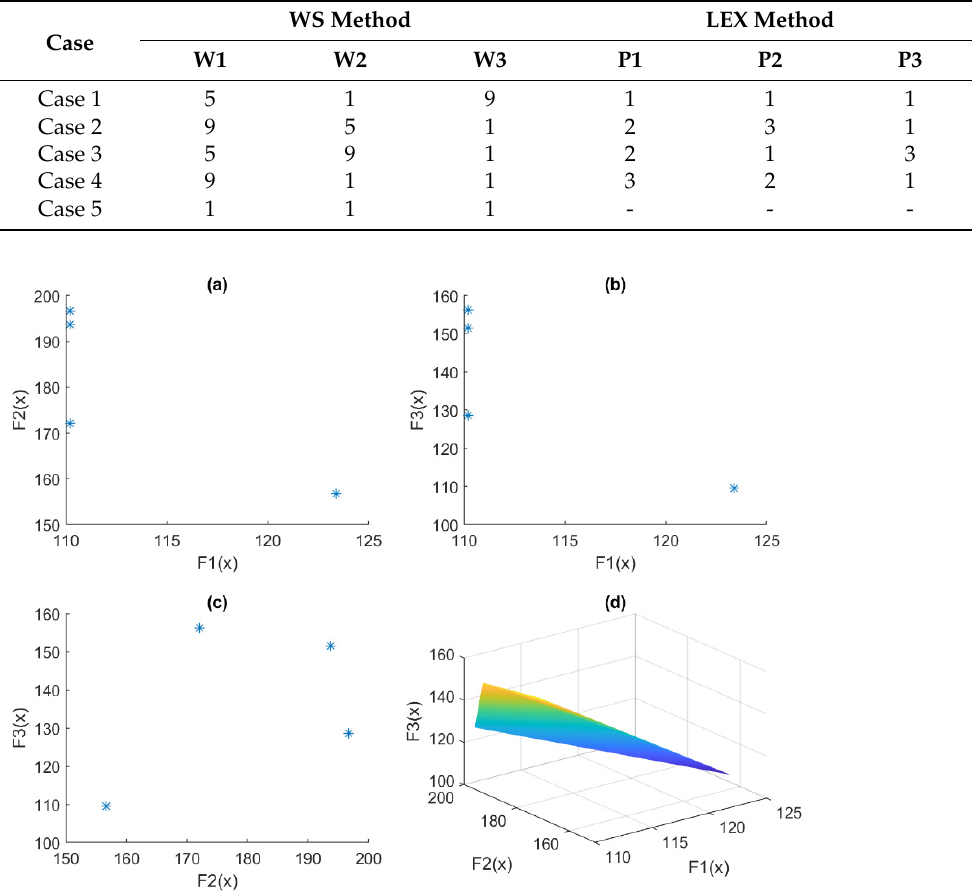
Table 2. Weights used for WS and LEX methods.